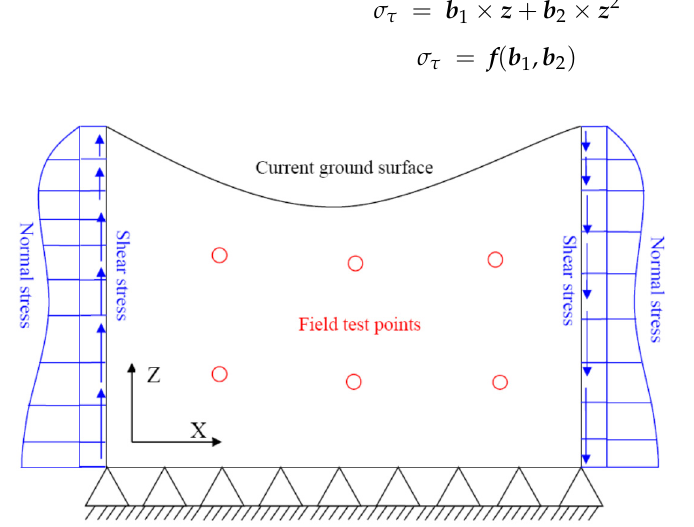
Figure 2. Sketch of normal and shear stress boundary.